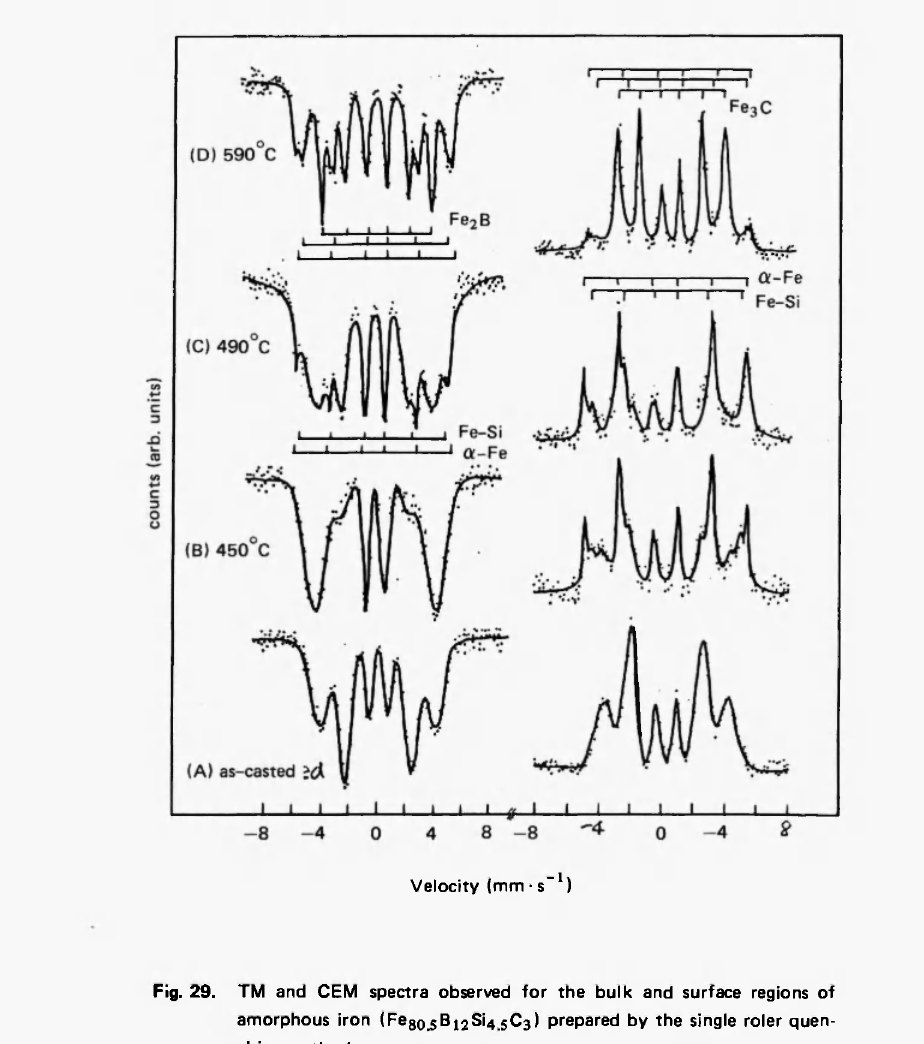
Fig. 29. TM and CEM spectra observed for the bulk and surface regions of amorphous iron (Fe 80 ^Bi2Si4 5C3) prepared by the single roler quen- ching